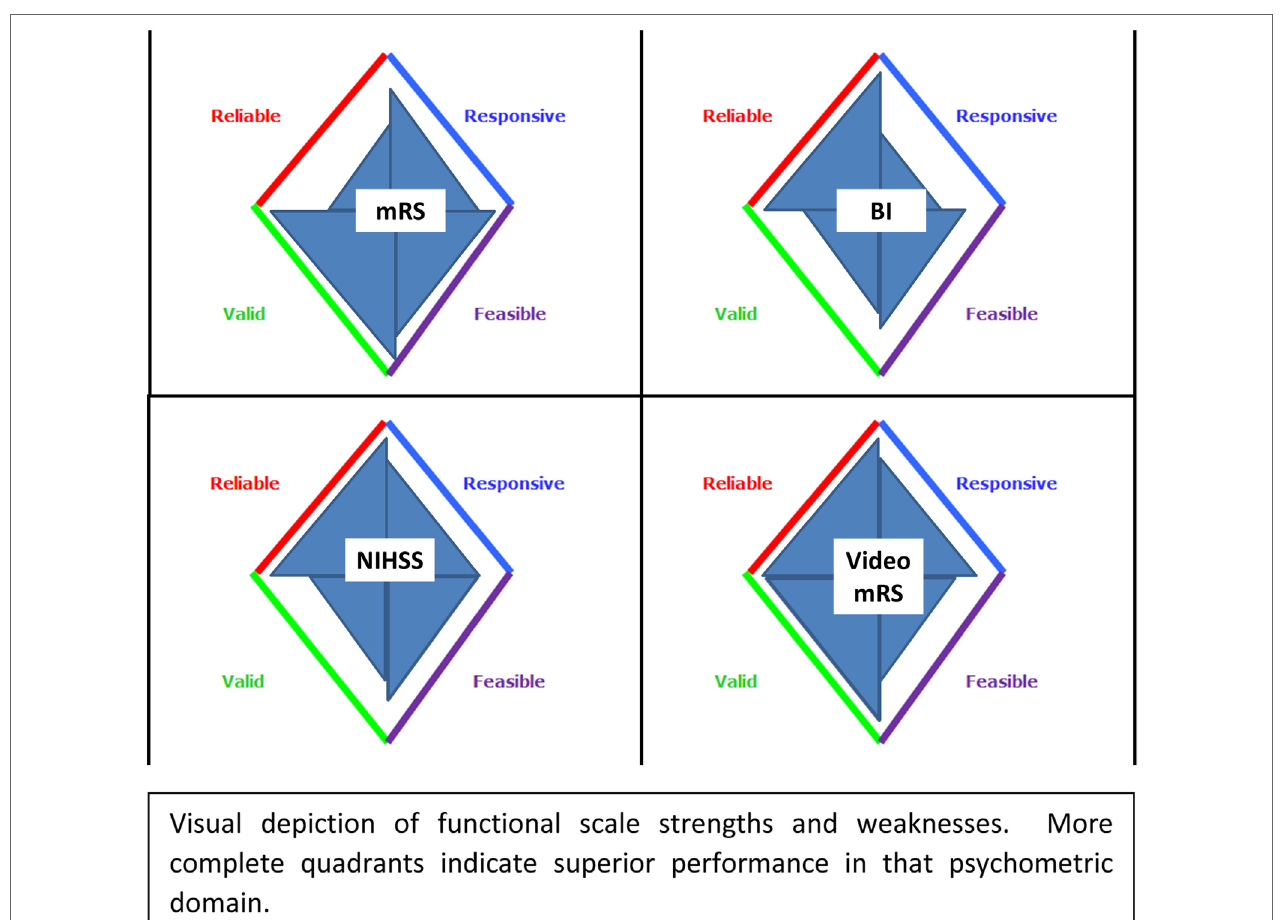
FiGURe 2 | Functional scale psychometric